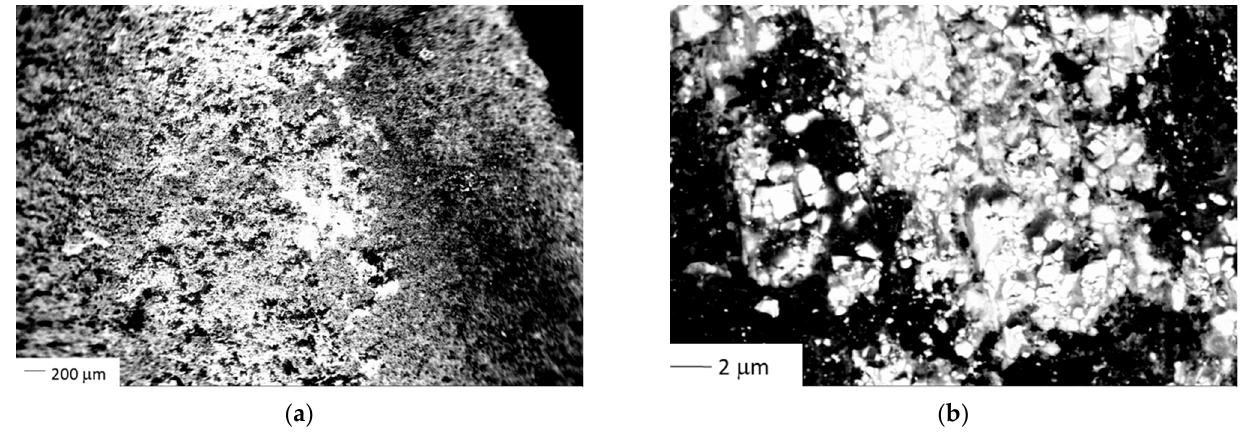
Figure 14. SEM micrograph ( a ) and a magnification ( b ) of wear tracks of WC-Co.